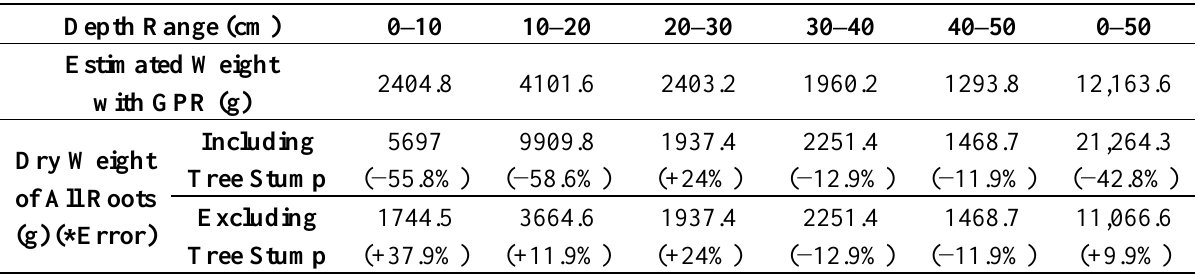
Table 2. Comparison of the estimated results of biomass with Ground Penetrating Radar (GPR) and the measured actual biomass at each 10 cm depth